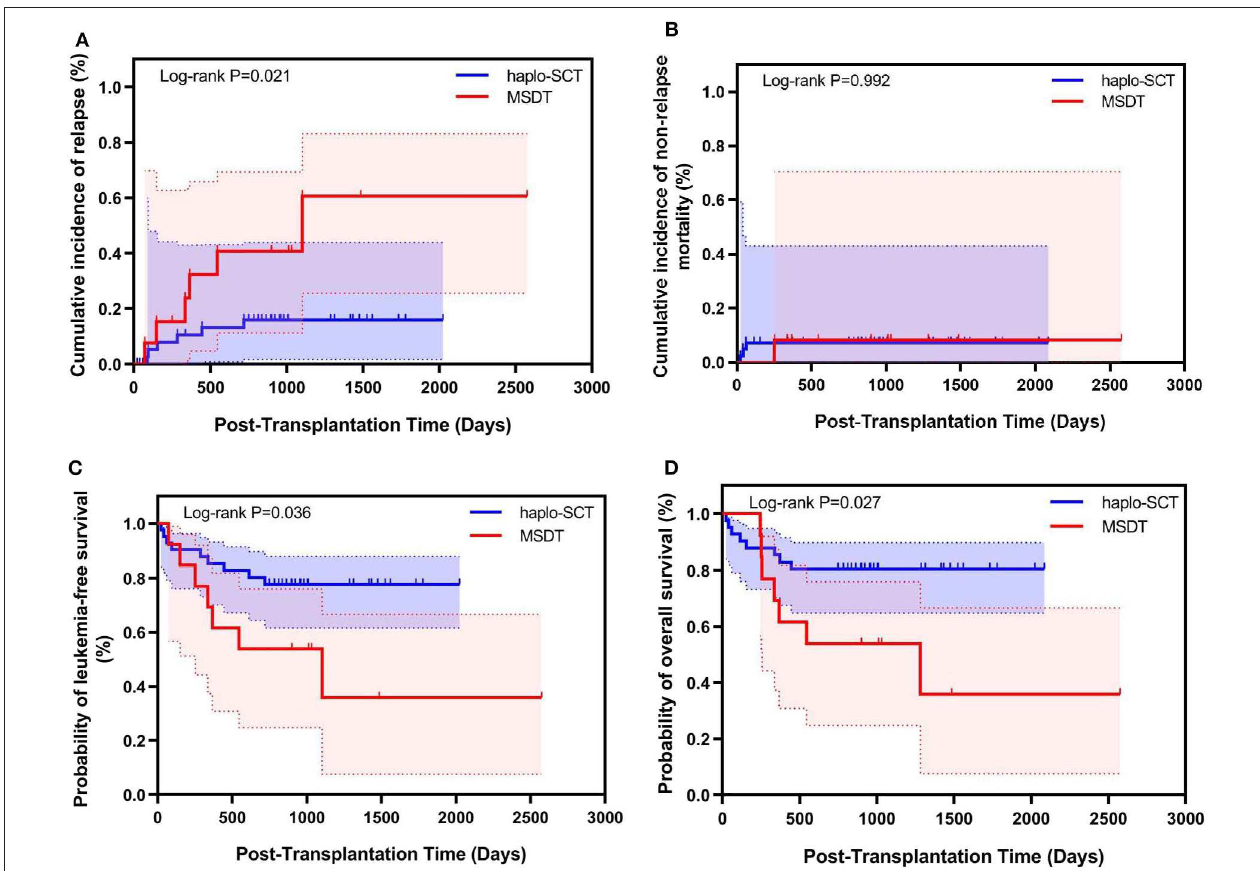
FIGURE 3 | Relationship between transplant modality and transplant outcomes for Ph-positive ALL patients with pre-transplantation MRD who underwent allo-SCT ( n = 54). Kaplan–Meier estimates of (A) cumulative incidence of relapse mortality, (B) cumulative incidence of non-relapse, (C) leukemia-free survival, and (D) overall survival.